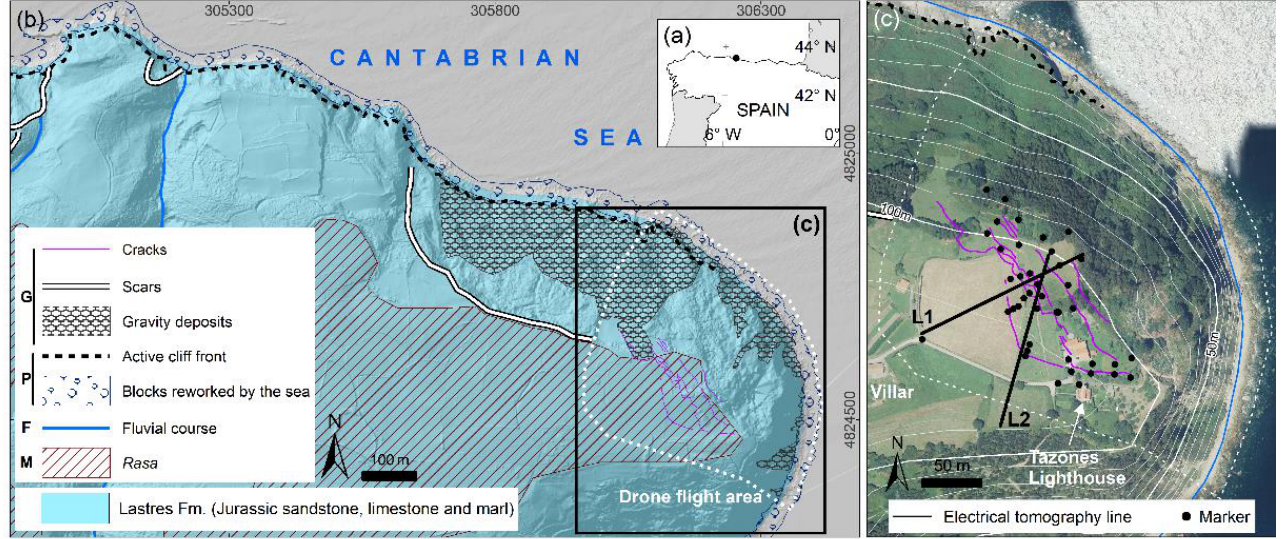
Figure 1. ( a ) Location of the study area in the North of Spain. ( b ) Lithology [25] and main geomor- phological aspects of the study area (M, marine; F, fluvial; P, polygenic; G, gravity). Terrain model: LIDAR-PNOA 2012 CC-BY 4.0scne.es. UTM coordinates ETRS89 30T. ( c ) Location of the electrical tomography lines, markers and main cracks in the surroundings of the Tazones Lighthouse. Back- ground image: OrtoPNOA 2017 CC-BY 4.0